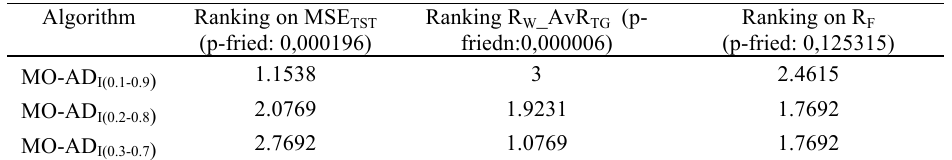
Table A.1 Rankings obtained through Friedman’s test for different values of thresholds on MSE TST , R W _AvR TG and #R F measures using WM rule bases for MAX ACC point.